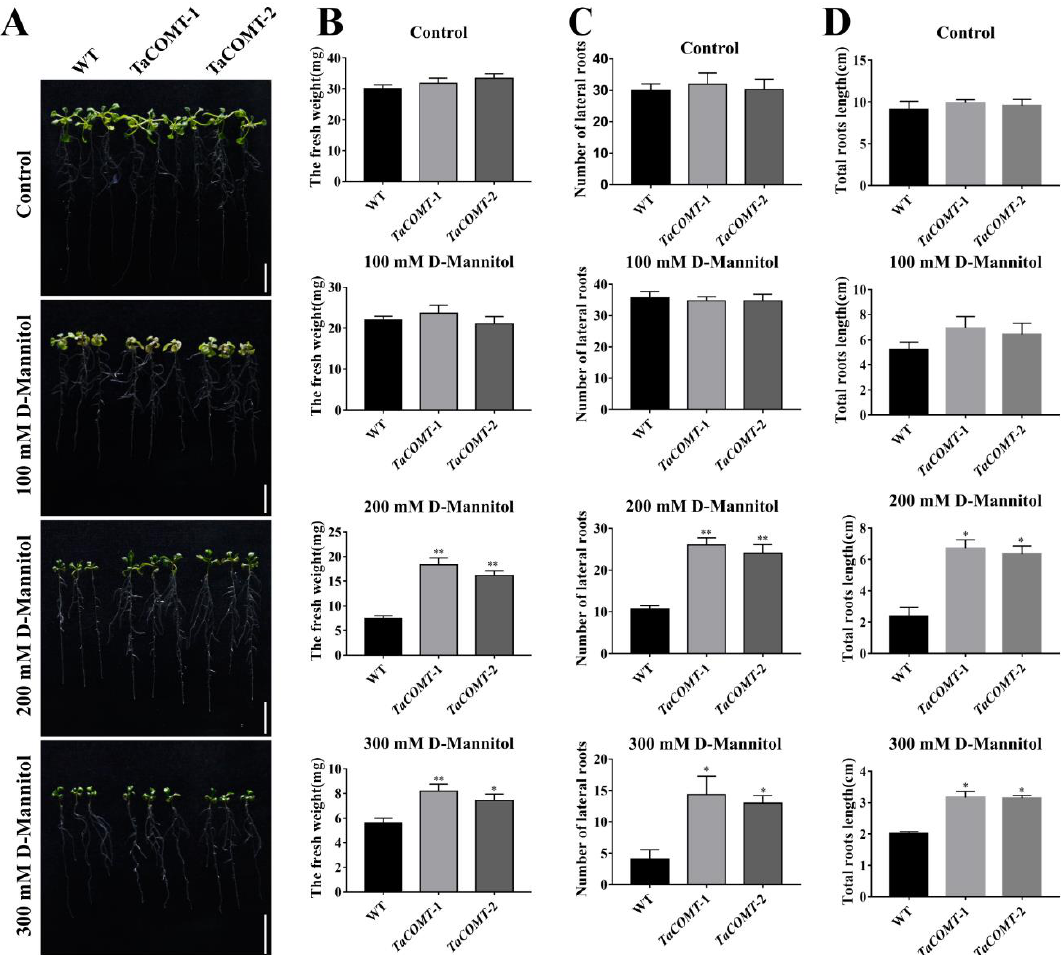
Figure 3. The phenotype of TaCOMT transgenic lines under D-Mannitol treatment. Six-day-old seedlings of WT and TaCOMT transgenic lines were transferred to ½ MS medium containing 0, 100, 200, or 300 mM D-Mannitol. A week later, the phenotype of roots was investigated (bar = 2 cm) ( A ). The statistical results of fresh weight ( B ), number of lateral roots ( C ), and total root length ( D ) of wild type (WT) and transgenic lines are shown in Figure 5. At least 25 seedlings per phenotype were counted. The data are shown as the means ± SDs ( n = 25) of three experiments. ANOVA test identified significant differences (* p < 0.05, ** p <